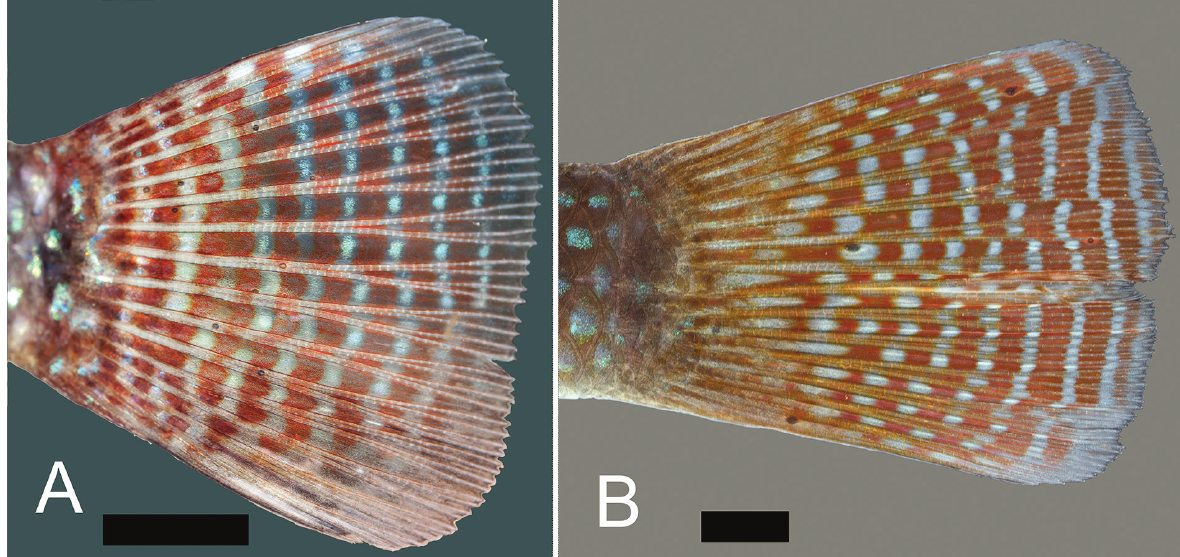
Figure 5. Caudal fin colour pattern. A Geophagus multiocellus , UFRJ 8217, topotype. B Geophagus santosi , UFRJ 9998, topotype. Scale bar 10 mm. Photographs by J.L.O. Mattos.